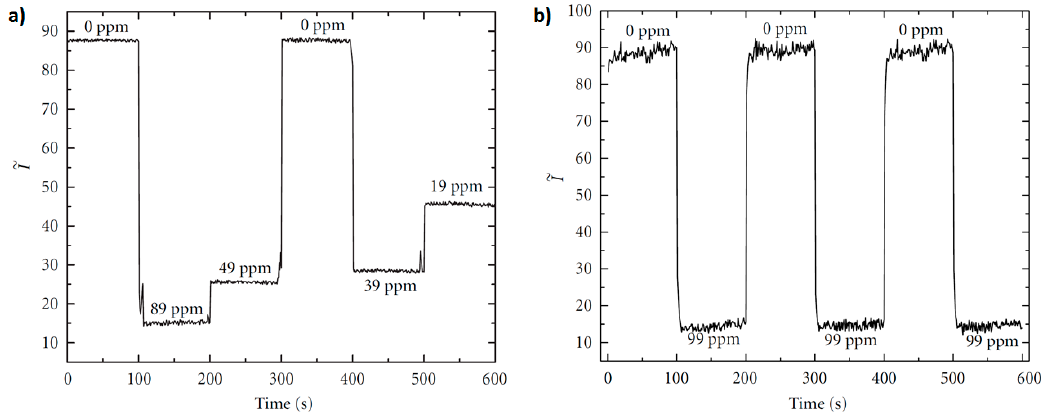
Figure 6. ( a ) Reversibility of the sensor response to DO changes; ( b ) Sensor response to switching from nitrogen-saturated to fully oxygenated environments. Reprinted with permission from Ref. [44].